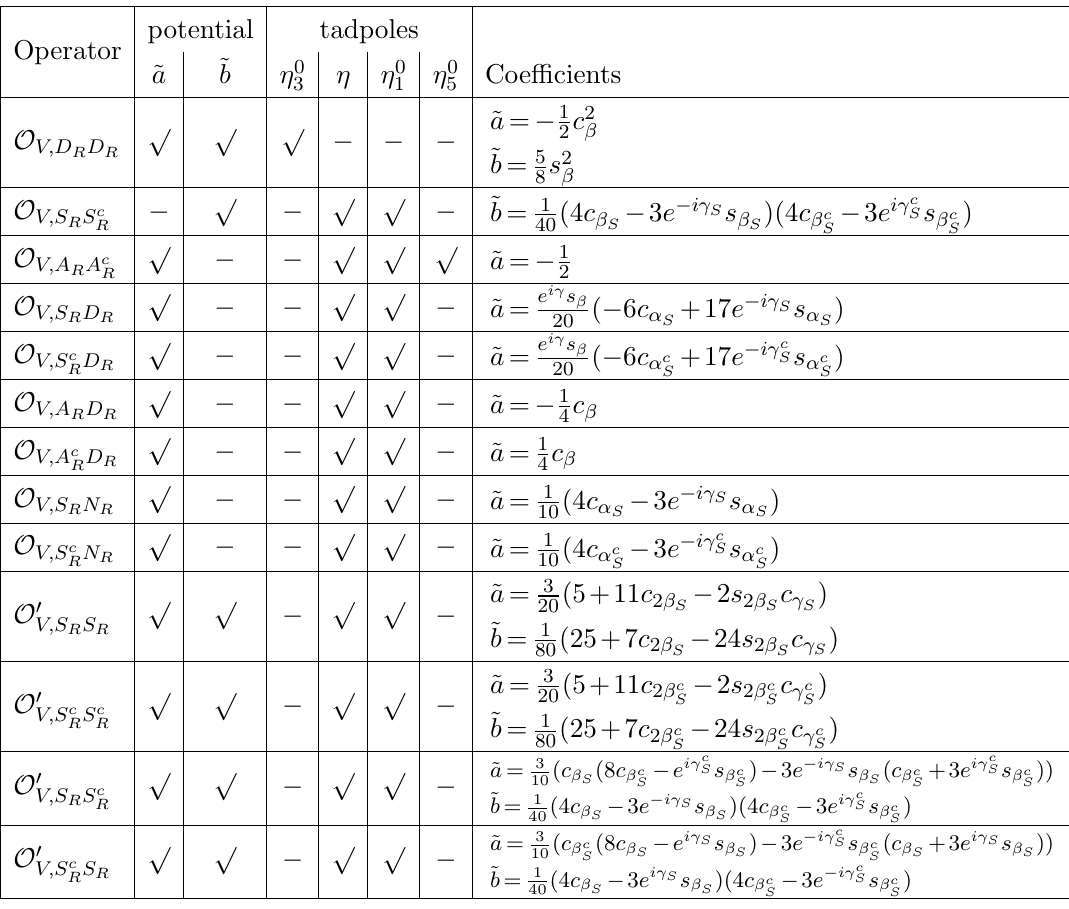
Table 3 . Same as table 2, but for operators containing right-handed